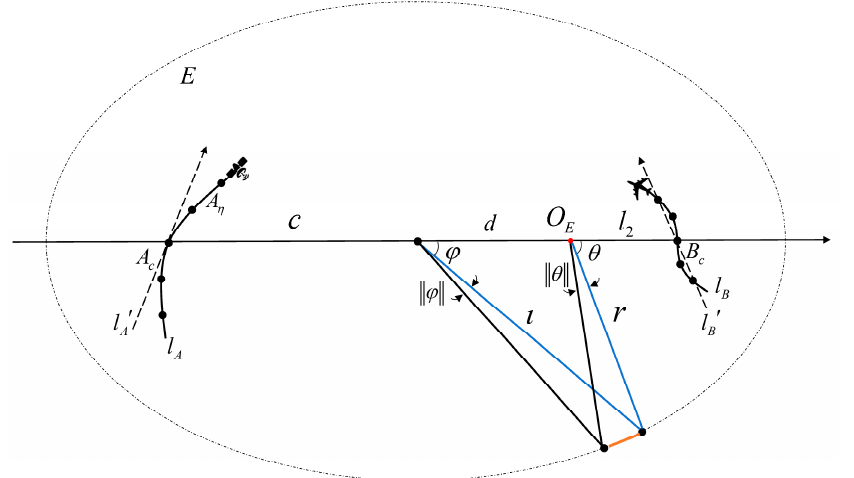
Figure 5. Analysis of the angular dimension sampling requirement of the subimages in both EP and OEP systems for the same imaging scene.